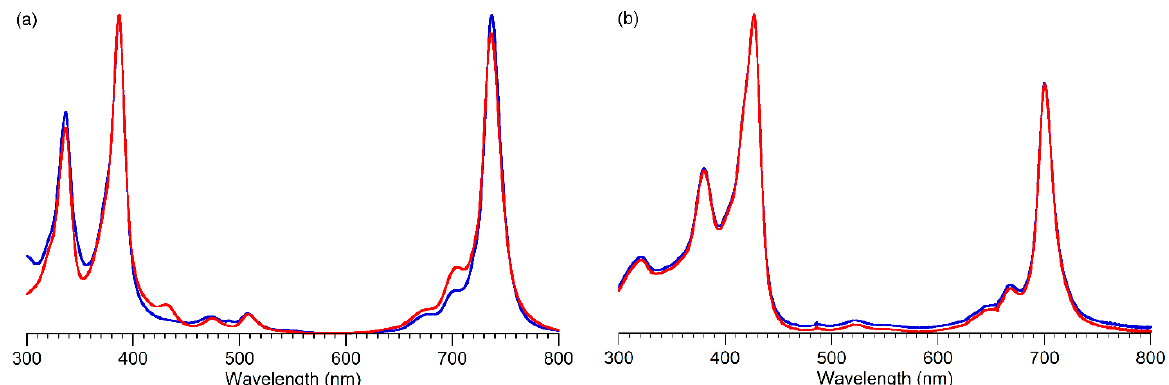
Figure 3. Panel ( a ): Absorption spectrum of CuBC-1 (blue line) and CuBC-2 (red line) in CH 2 Cl 2 at room temperature (normalized in the B band). Panel ( b ): Absorption spectrum of CuBC-3 (blue line) and CuBC-4 (red line) in CH 2 Cl 2 at room temperature (normalized in the B band). The resonance Raman (RR) spectra of CuBC-1 and CuBC-2 were examined. Q y -exci-